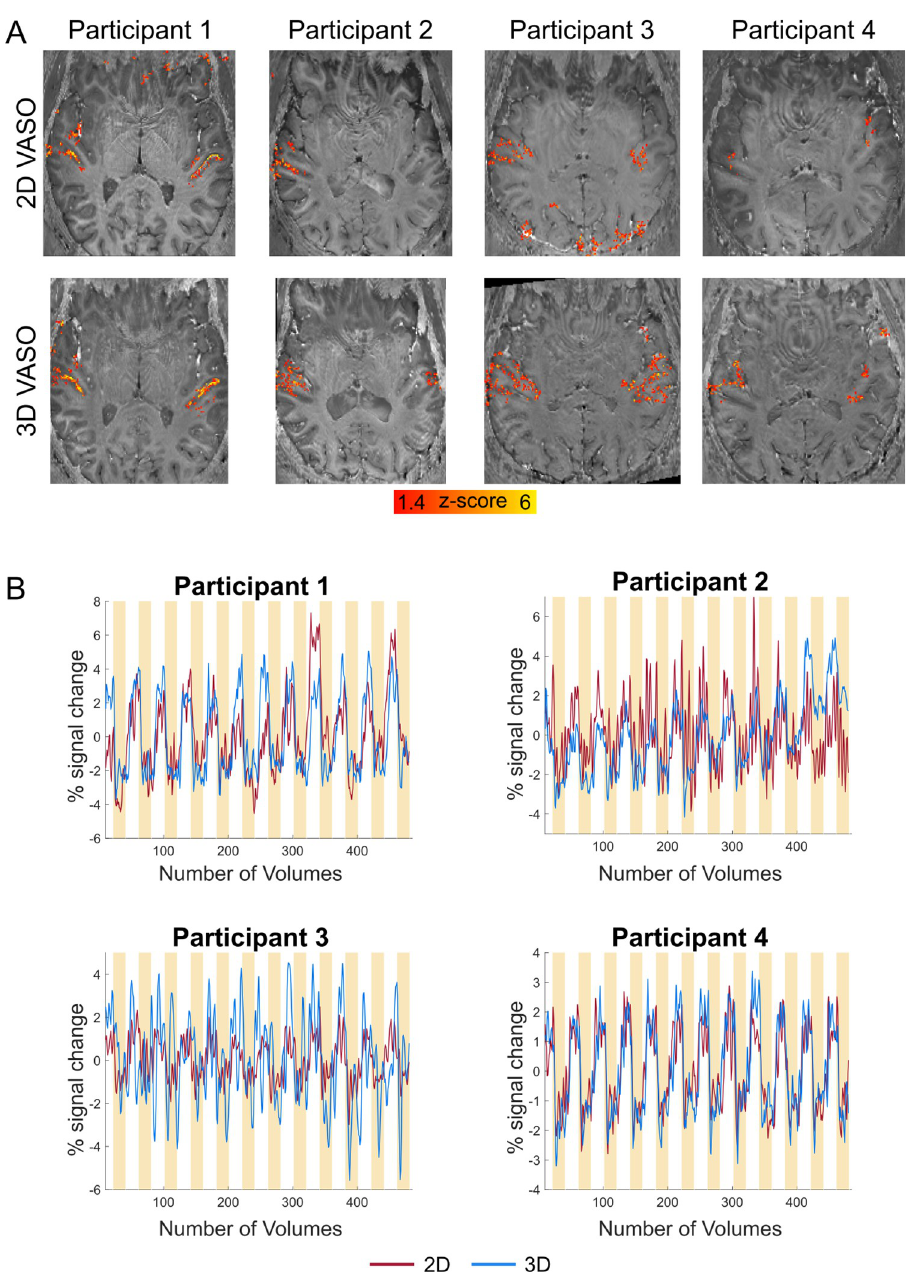
Fig 2. Activation maps and time courses of VASO. (A) Z-scored activation maps overlayed on distortion corrected mean EPI images (per participant and readout). For our data, using a 3D-EPI readout seems to be beneficial in VASO. (B) VASO time courses (average coming from active voxels) calculated in percent signal change illustrate the negative percent signal change when auditory stimuli are presented. Yellow bars indicate the presentation of auditory stimuli.